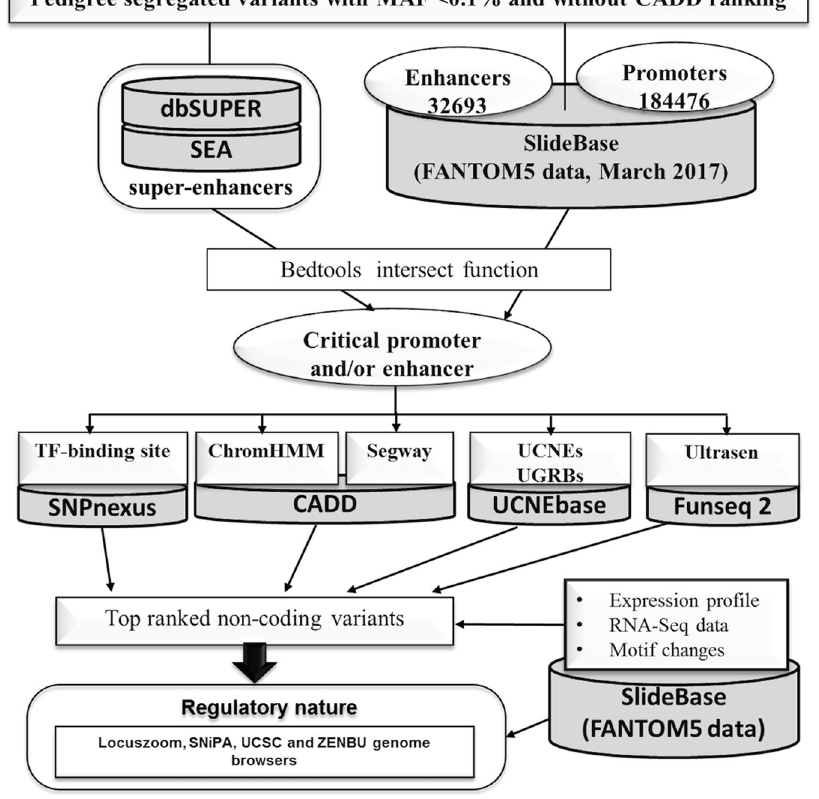
Figure 2. Overview of strategies for regulatory variant detection in the non-coding segments of the human genome. We utilized the FANTOM5 data using the SlideBase Tool ( slidebase.binf.ku.dk ) with 32693 enhancers and 184476 promoters (downloaded in March 2017). We matched our variants (pedigree segregated) with FANTOM5 data using Bedtools intersect to retrieve a list of potentially critical variants localized within promoters and/or enhancers, and we examined the status of transcription factor (TF) binding sites using SNPnexus 9 . We checked the signals for chromatin binding using ChromHMM and genomic segmentation data from Segway via CADDv1.3 20 . In addition, we examined if the putative noncoding regulatory variants were localized in the ultra-conserved non-coding elements (UCNEs) and their clusters, also known as ultra- conserved genomic regulatory blocks (UGRBs) with the help of UCNEbase 24 and also if these variants were located in ultra-sensitive and sensitive regions (Ultrasen), defined by FunSeq2 23 . The top-ranked variants were examined for their regulatory nature by using Locuszoom, SniPA, UCSC and ZENBU genome browsers. We also examined if the putative enhancer variant fall into the category of super-enhancers using super-enhancer archive (SEA) 25 and dbSUPER 26 . Expression profile, RNA-seq data-based information and motif changes and disruptions were gathered with help from FANTOM5 data via the